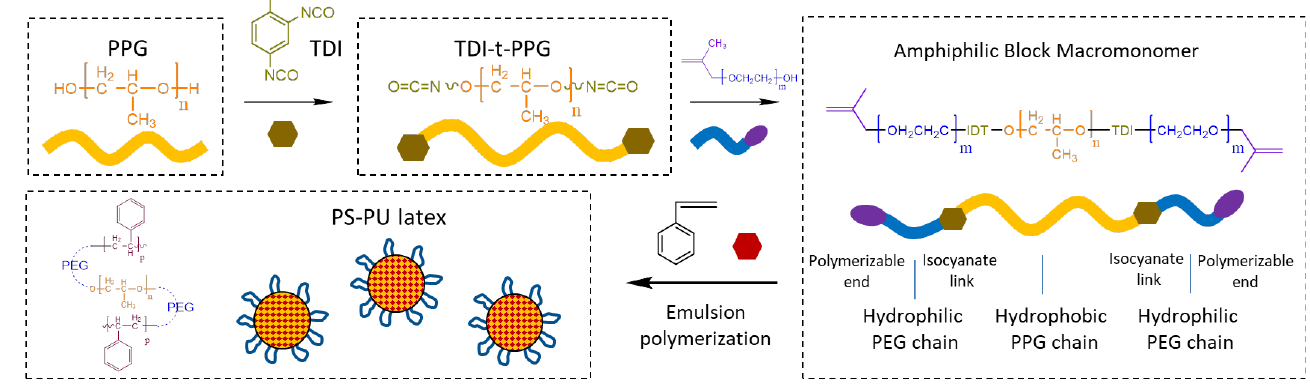
Figure 1. chemical route for the preparation of